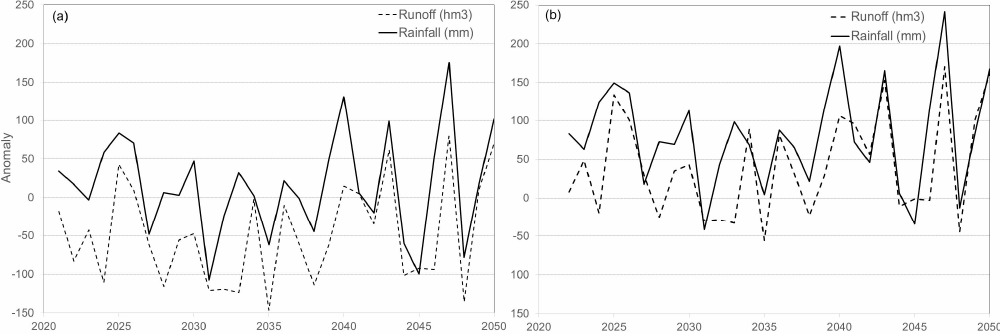
Figure 9. Projected anomalies 2021–2050 of rainfall and runoff related to the mean for: ( a ) the 1961– 1990 and ( b ) the 1971–2000 period. and ( b ) the 1971–2000 period. Table 2. Contrast of mean annual runoff, rainfall and PET for Fuensanta Basin. Table 2. Contrast of mean annual runoff, rainfall and PET for Fuensanta